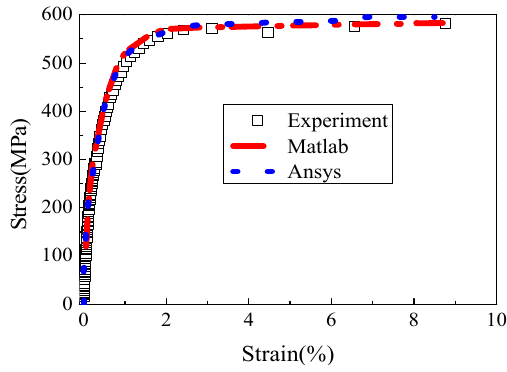
Figure 16. Uniaxial tensile verification curve.